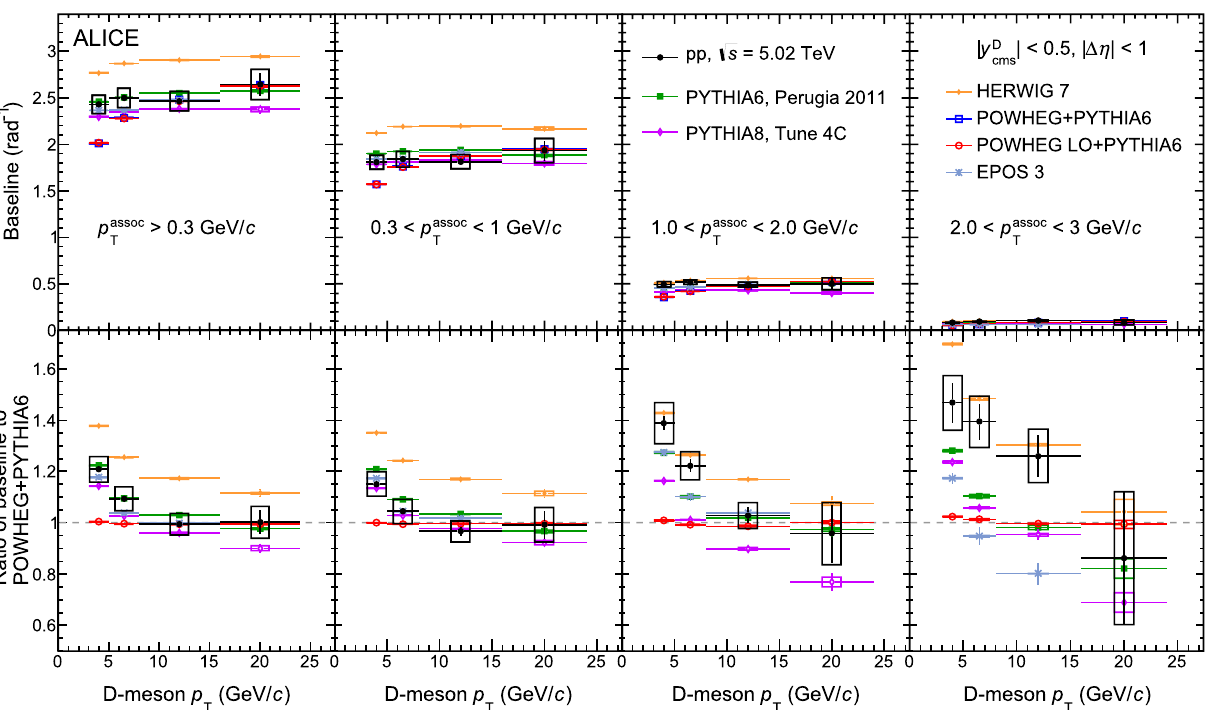
Fig. 11 Measurements of azimuthal-correlation function baseline √ s = 5 . 02 TeV, compared to predictions height in pp collisions at by the PYTHIA, POWHEG+PYTHIA6, POWHEG LO+PYTHIA6, HERWIG, and EPOS 3 event generators with various configurations in the top row (see text for details). The ratios of baselines with